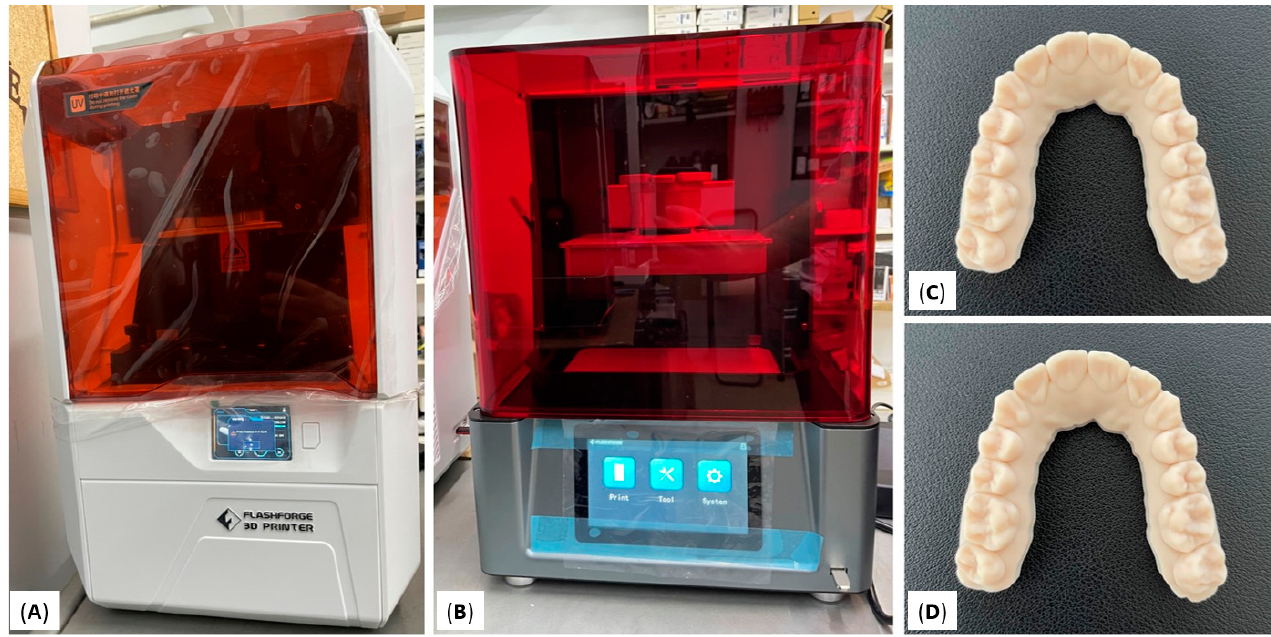
Figure 1. ( A ) LCD 3D printer, Flashforge Focus 9.25 6K; ( B ) DLP 3D printer, Flashforge Hunter; ( C ) printed model with Flashforge Focus 9.25 6K; ( D ) printed model with Flashforge Hunter. All 10 STL files were printed once with each printer in order to evaluate the trueness